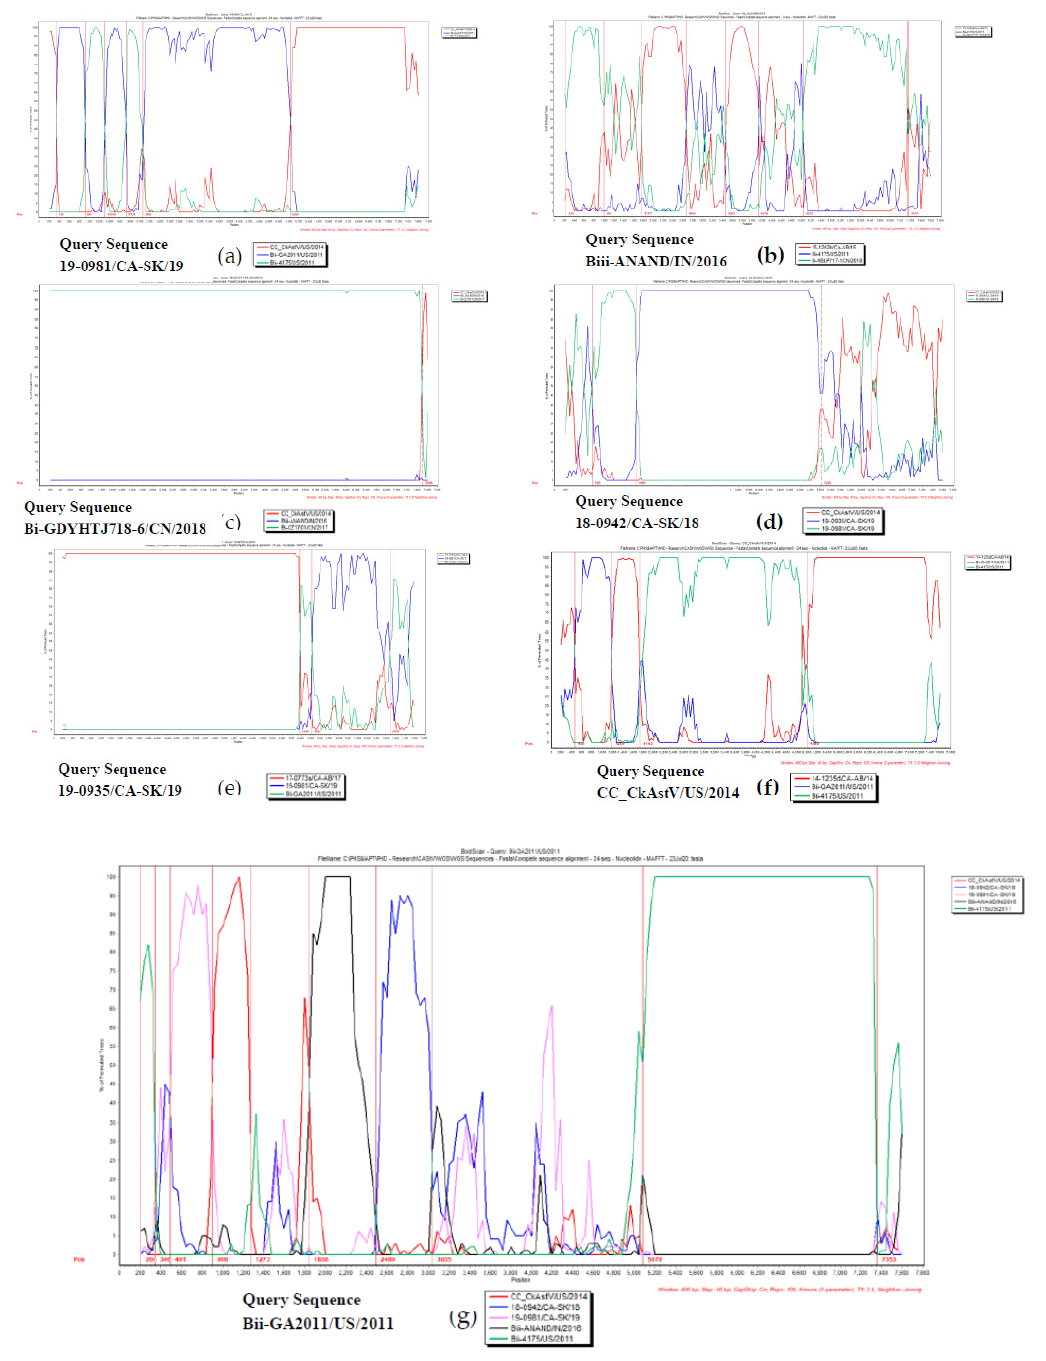
Figure 5. Bootscan analysis of recombinant CAstV sequences for confirming recombination was performed using Simplot program v3.5.1. Each analysis considers different parent sequences (different colors) plotted in a graph considering in the vertical-axis Percentage of permuted trees, and on the horizontal axis, position on the genome of the query sequence. Recombinant CAstV query sequences are 19-0981/CA-SK/19 (Supplementary Figure S3a); Biii-ANAND/IN/2016 (Supplementary Figure S3b); Bi-GDYHTJ718-6/CN/2018 (Supplementary Figure S3c); 18-0942/CA-SK/18 (Supplementary Figure S3d); 19-0935/CA-SK/19 (Supplementary Figure S3e); CC_CkAstV/US/2014 (Supplementary Figure S3f); and Bii-GA2011/US/2011 (Supplementary Figure S3g).